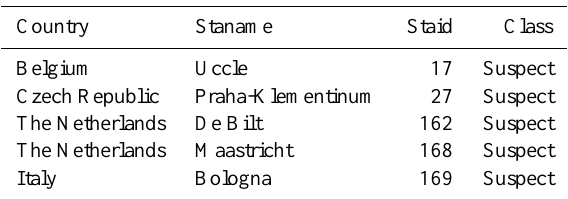
Fig. 2. One-year moving average of the maximum temperature in Bologna after removal of the mean annual cycle. Table 1. Excerpt of table TEMP 19012007 homogeneity.txt from ECA&D on the results of homogeneity checks for 1901–2007 pe-